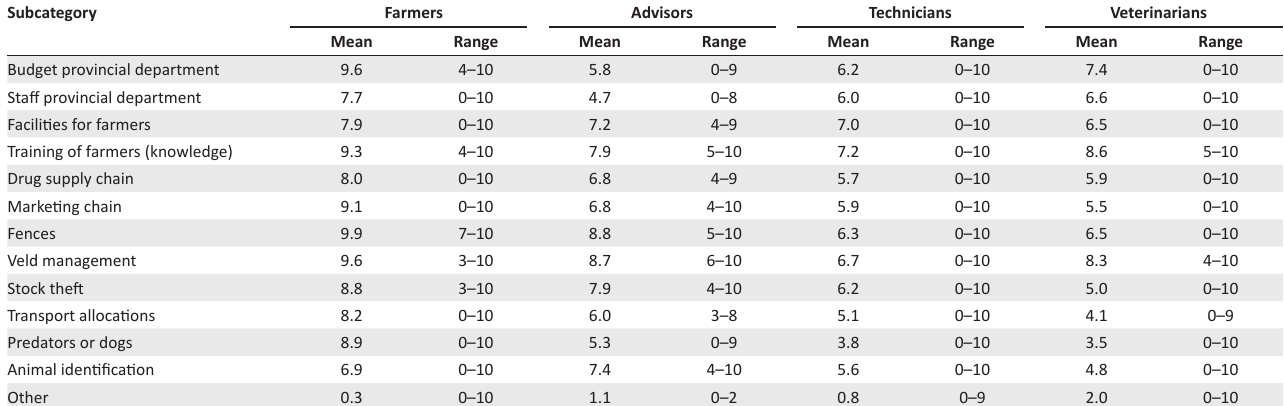
TABLE 4: Major constraints to profitable small-stock farming. Subcategory Farmers Advisors